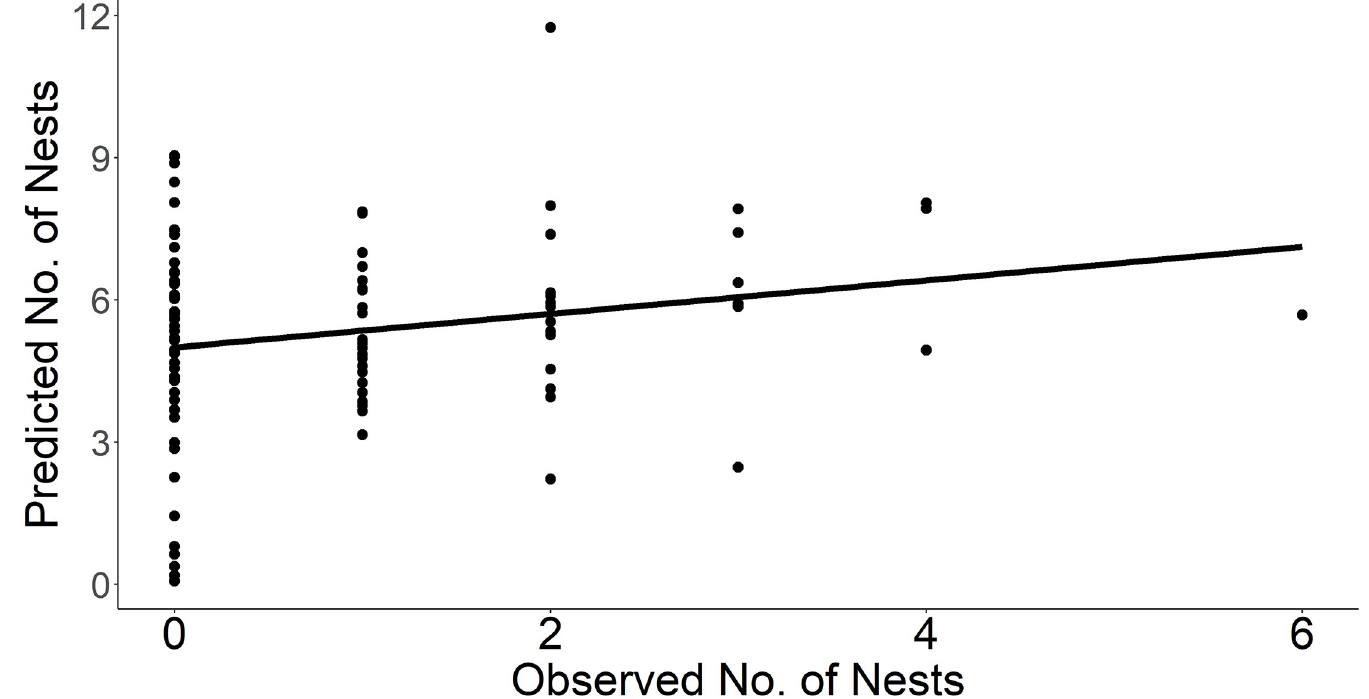
Fig 2. Estimated and observed chestnut-collared longspur nests per study plot. Estimated and observed (raw counts) number of chestnut-collared longspur nests at100, 9-ha plots in Phillips County, MT during May–July of 2017 and 2018. The Pearson’s correlation coefficient indicated a weak positive correlation ( r = 0.2, P =